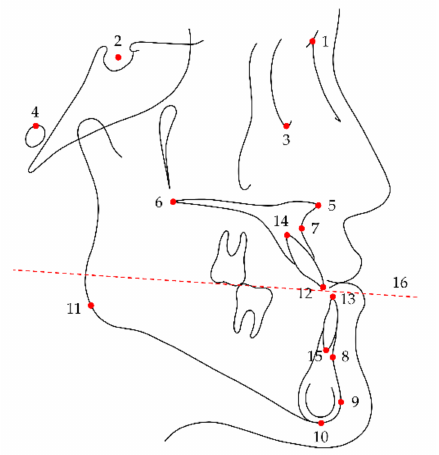
Figure 1. Cephalometric landmarks and reference plane used in this study: 1, nasion; 2, sella;